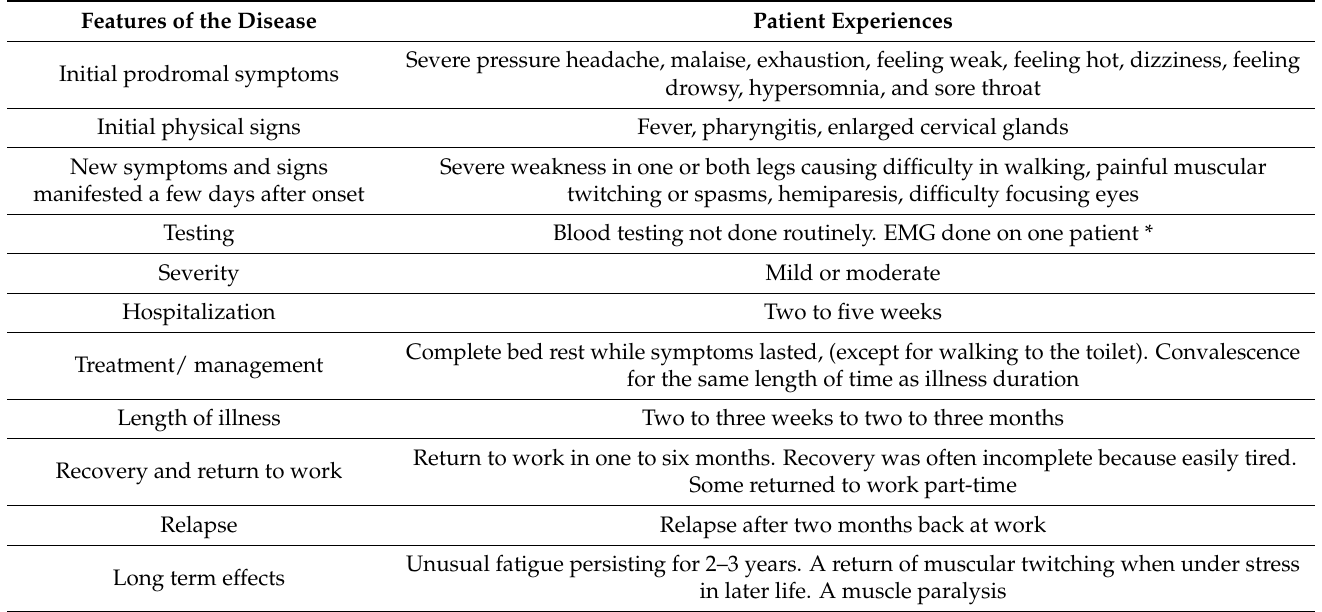
Table 2. Patients who developed Royal Free